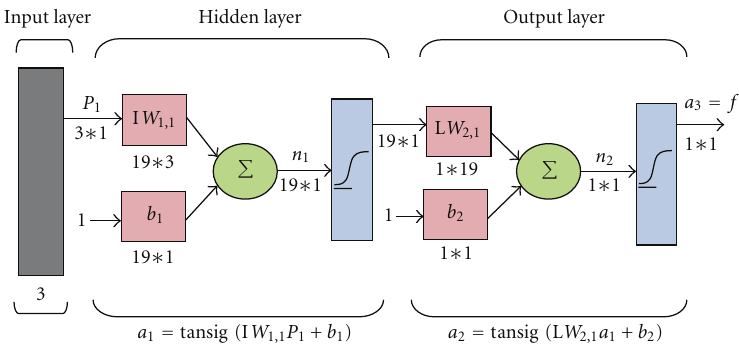
Figure 3: Detailed structure of the used ANN.